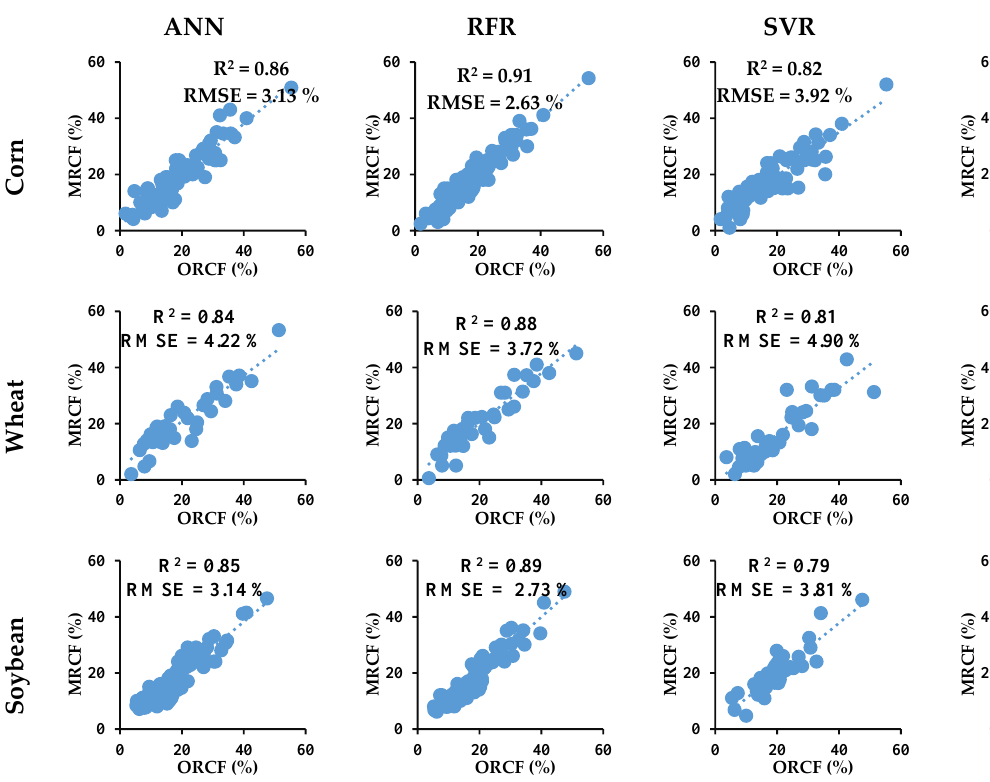
In the first scenario (dataset including reflective band-based spectral indices), based on calibration data, the R 2 (RMSE) between the actual and modeled RCF using ANN, RFR, SVR and PLSR algorithms for corn crop were 0.86 (3.13), 0.91 (2.63), 0.82 (3.92) and 0.79 (4.22%), respectively (Figure 3). These values were 0.84 (4.22), 0.88 (3.72), 0.81 (5.25) and for soybean. The efficiency of RCF modeling using different machine learning algorithms based on spectral indices was different. The RFR and PLSR algorithms had the highest and lowest accuracy in forming an optimal network for RCF modeling, respectively.